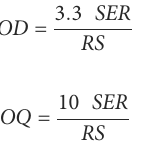
TABLE 1 Neutral monosaccharide composition of water-insoluble cell wall material isolated from leaf tissue of cool-season forage species. Forage species